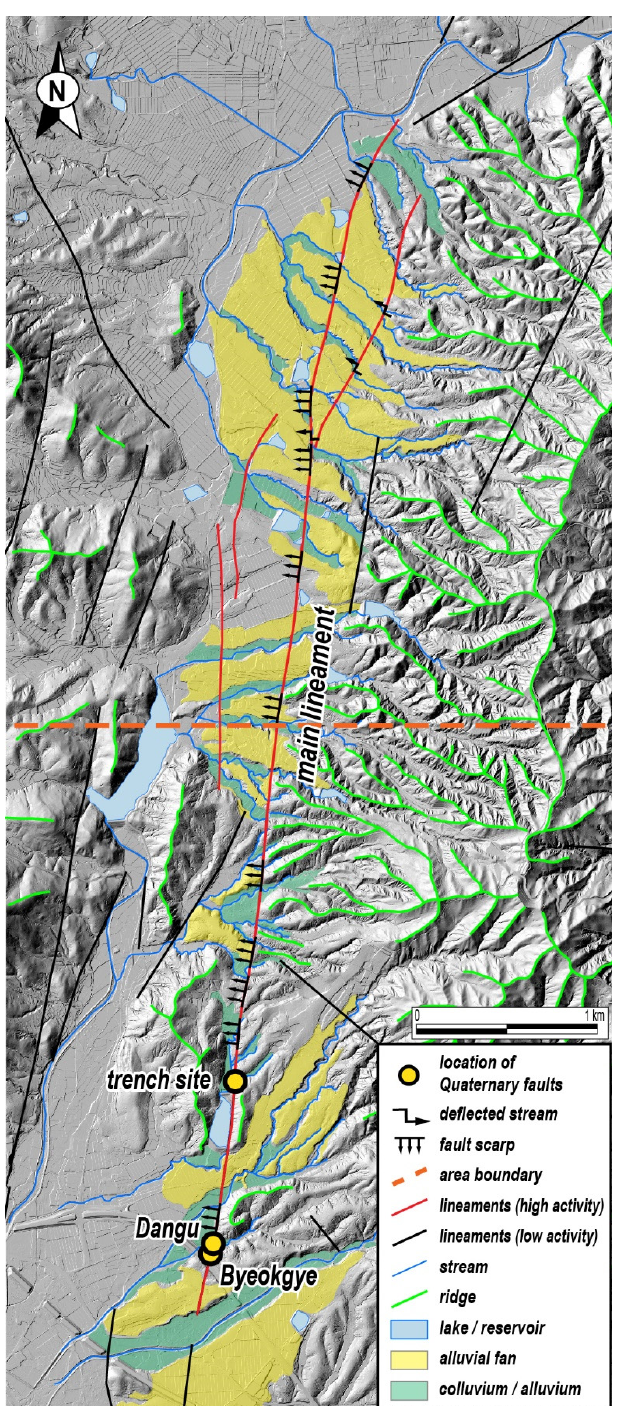
Figure 5. Geomorphic mapping results of the study area using LiDAR imaging. The fault scarp is recognized along a main lineament extending northward from the previous studies sites (i.e., Byeokgye and Dangu). The study area is divided into two areas for detailed analysis. Each fault scarp is differentiated from other fluvial and man-made scarps by on-field confirmation considering its linear continuity and near-by connectivity using the different years of aerial photographs and topo-maps.